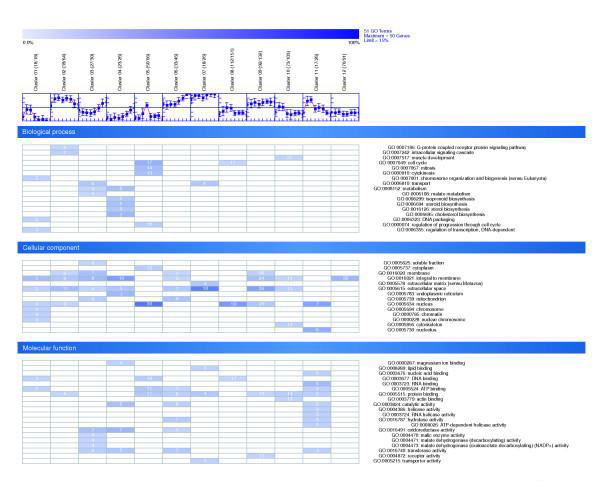
Distribution of GO terms for genes/ESTs in each cluster. The GO terms listed here are those present in at least 15% of the genes within the cluster. In brackets are the number of genes/ESTs with associated GO terms and the number of genes/ESTs within the cluster. EST, expressed sequence tag; GO, Gene Ontology.